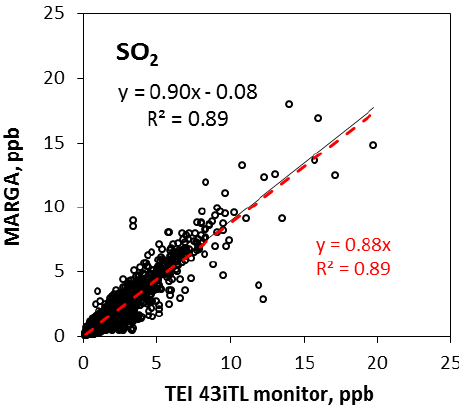
Fig. 6. Sulphur dioxide measured with the MARGA and a TEI 43iTL SO 2 monitor, all hourly averages. The linear regression with the black line and equation was calculated by fitting both the slope and the offset and the regression with the red dashed line and red equation by forcing the offset to zero.